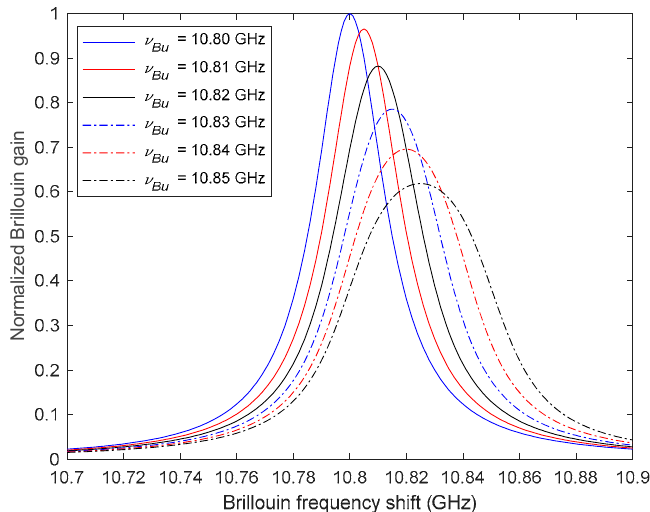
Figure 4. Normalized BGS at location z corresponding to linearly distributed strain fields.